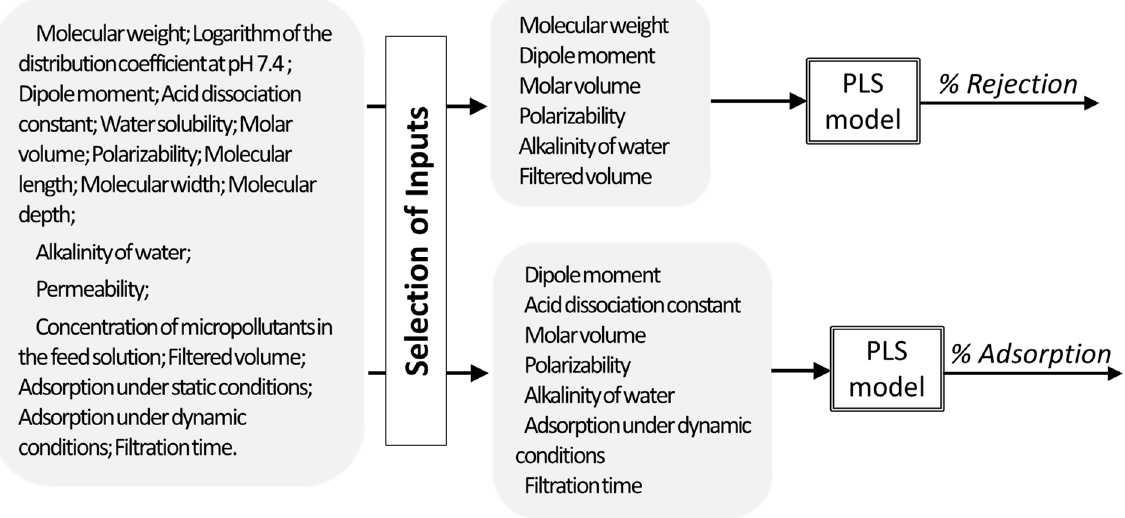
Figure 10. Input selection and PLS modelling of apparent rejection (% Rejection) and adsorption (% Adsorption) of micropollutants during nanofiltration of contaminated waters.